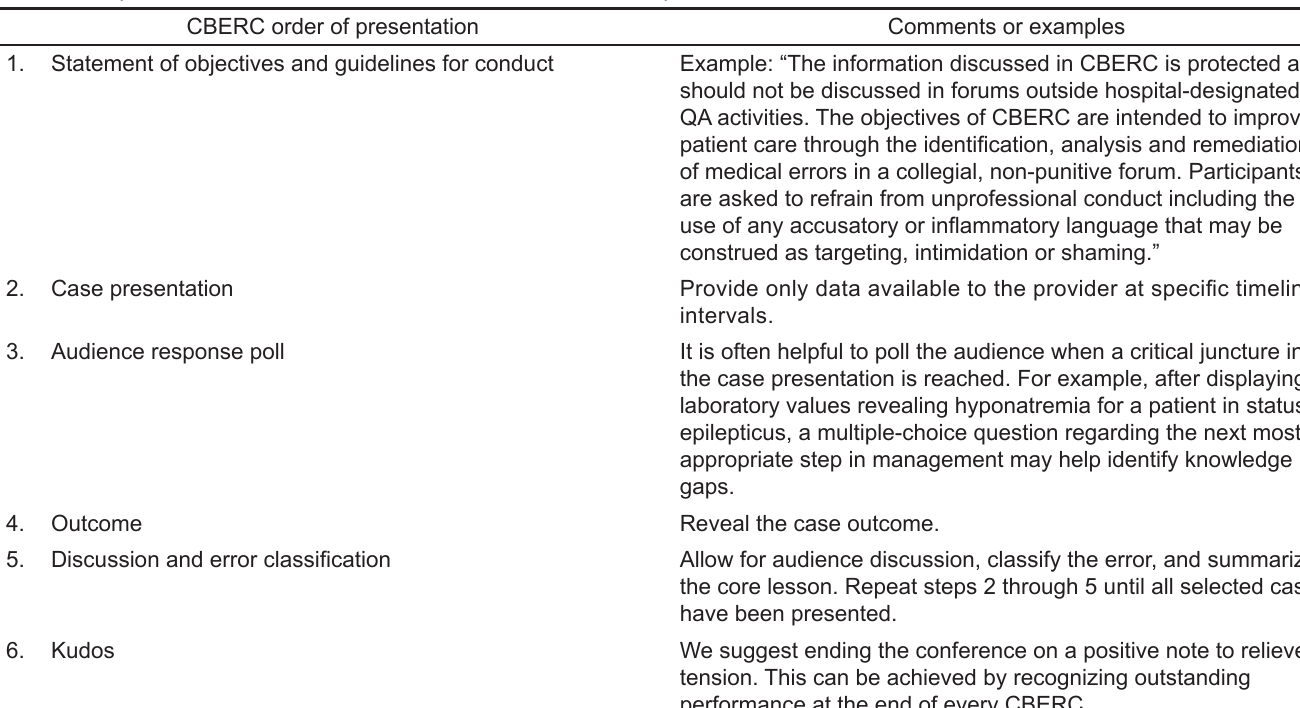
Table 8. Proposed order of case-based error reduction conference presentation.